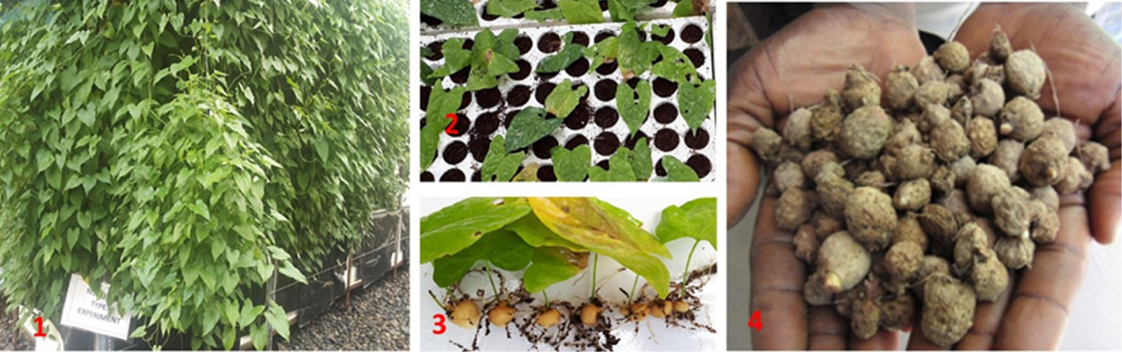
Figure 2. Production of minitubers. 1 = Yam plants in an aeroponics system; 2 = Nodal yam cuttings planted in a polystyrene nursery tray (Cuttings without shoots were allowed to produce minitubers, those that formed shoots were transplanted to the field); 3 = Minitubers produced after three months from single leaf cuttings (without shoots); 4 = Sprouted minitubers used in the exper- iment.